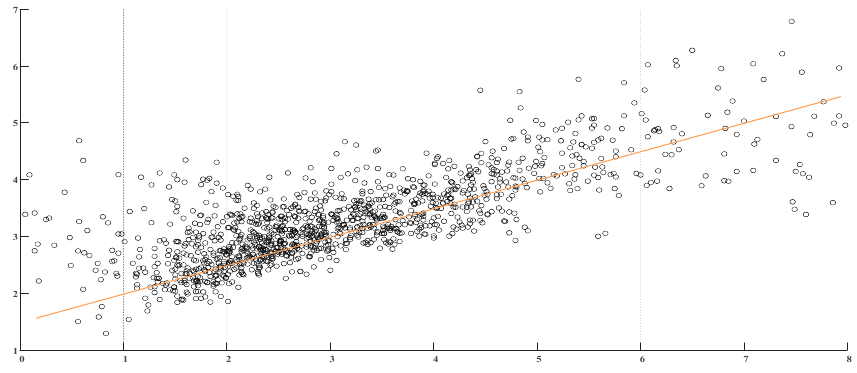
Figure 9. Calculation results of random forest (cleaning rate 95.97%).